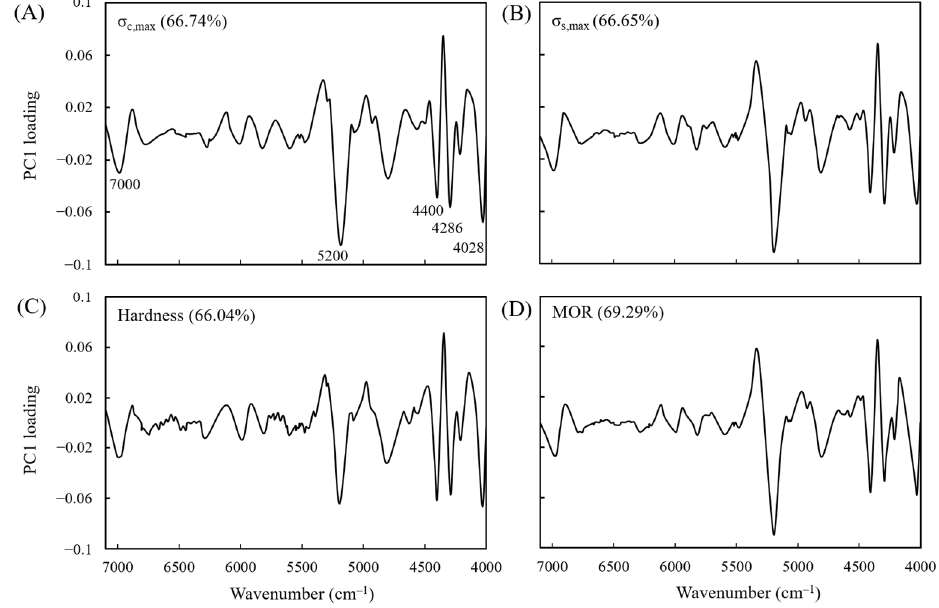
Figure 6. PLSR loading vectors for the ( A ) σ c,max , ( B ) σ s,max , ( C ) hardness, and ( D ) MOR in the prediction models.